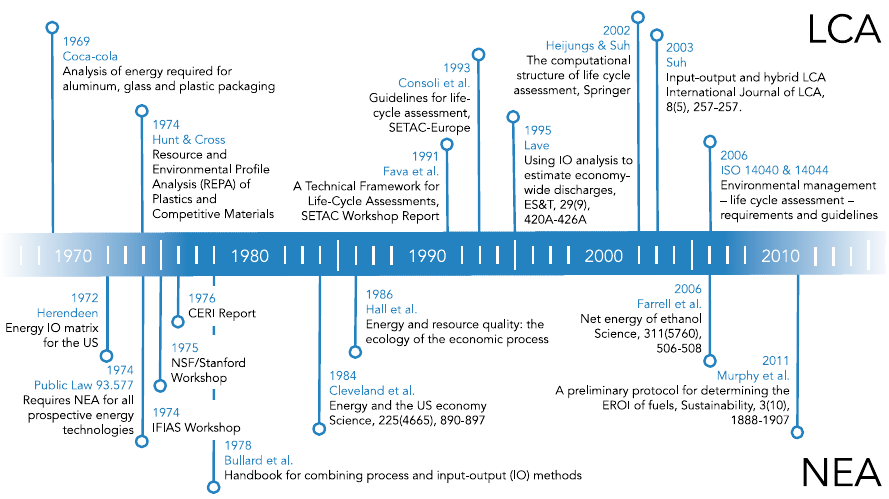
Figure 2. Timeline of seminal publications in both life cycle assessment (LCA) and net energy analysis (NEA).